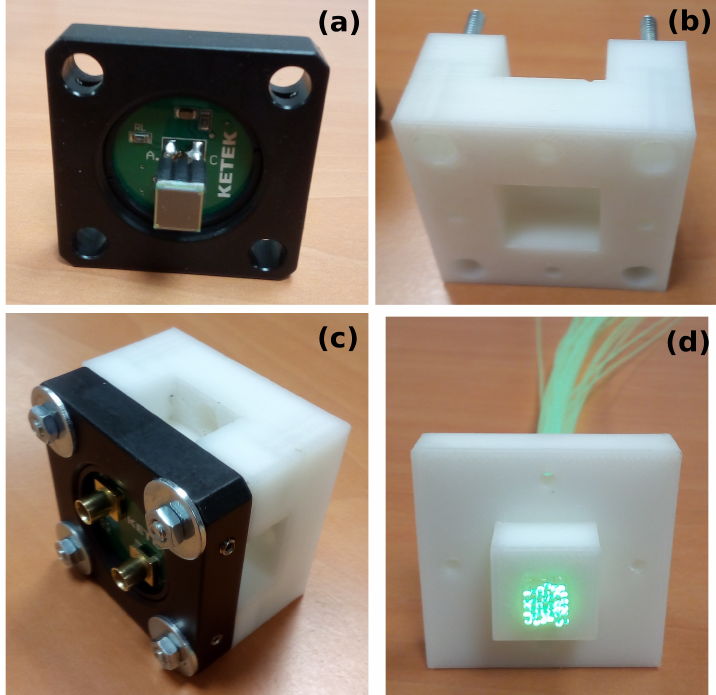
Figure 5. ( a ): The KETEK PM6650-EB SiPM attached to a small PCB board on a metal frame. ( b ): The bottom part of the 3D printed construct. This part is screwed on the PCB metal frame with the shown direction. ( c ): The back of the SiPM metal frame which is has been fitted on the bottom part of the 3D printed construct. ( d ): The top part of the 3D printed construct that holds the WLS fibers. The top part is screwed on the bottom